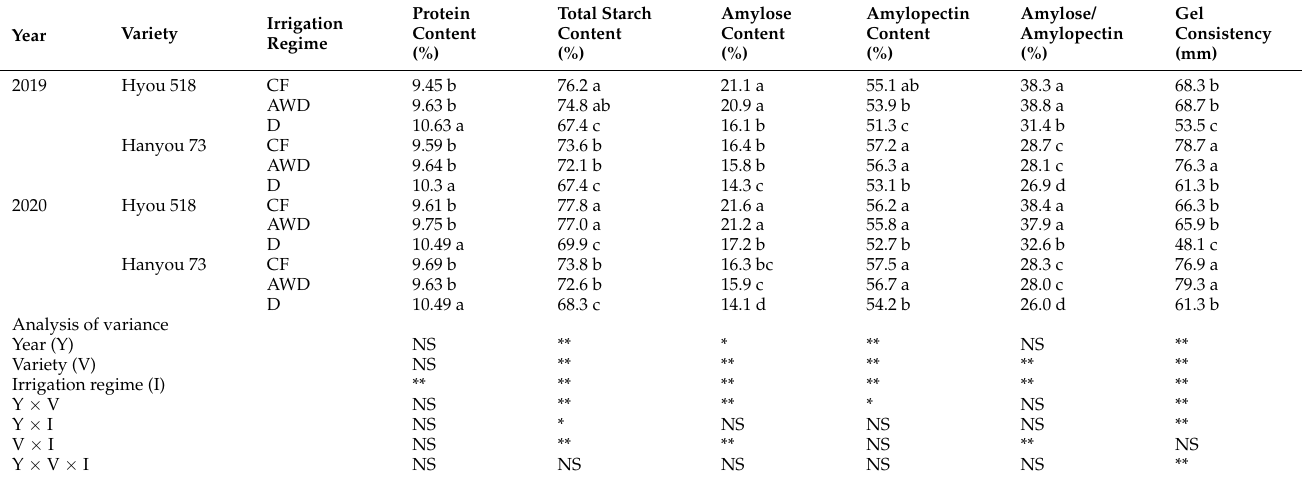
Table 3. Cooking and eating quality and nutritive quality under various irrigation treatments.